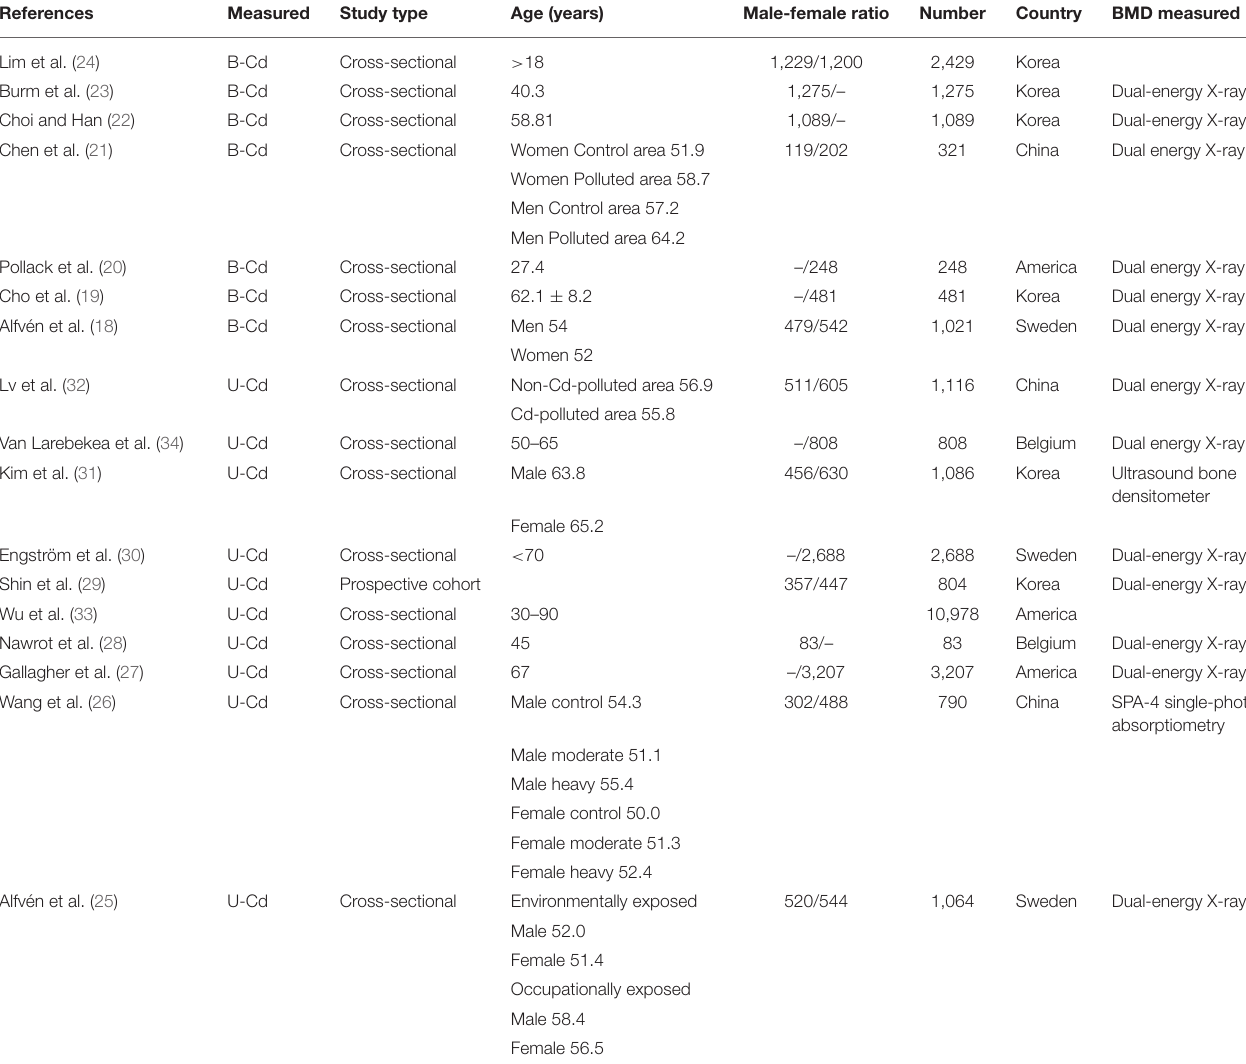
TABLE 1 | Summary characteristics of studies and